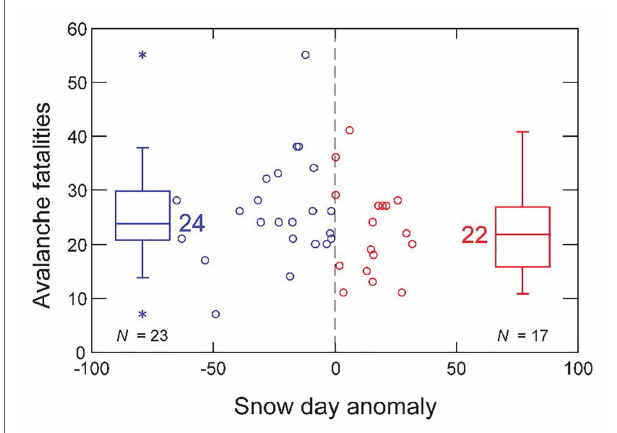
FIGURE 3 | Avalanche fatalities in the Swiss Alps for the 40-year period 1978–1979 to 2017–2018 in relation to snow cover duration, expressed as snow day anomaly. Snow day anomaly refers to the deviation from the mean number of snow days. Snow days are days with snow depth >50 cm for a group of seven measurement stations in the Swiss Alps at 1,300–1,800 m. The 30- year mean (1961–1990) is 89 days (Marty, 2008). Open circles show individual values, in blue for years with low snow and in red for years with high snow. Box plots to left and right show the distribution characteristics. The median numbers of fatalities were 24 in low snow years and 22 in high snow years. The difference between the two groups is not statistically significant (U-Test, p = 0.28). Same presentation of box plots as described in Figure 2 ; asterisks show